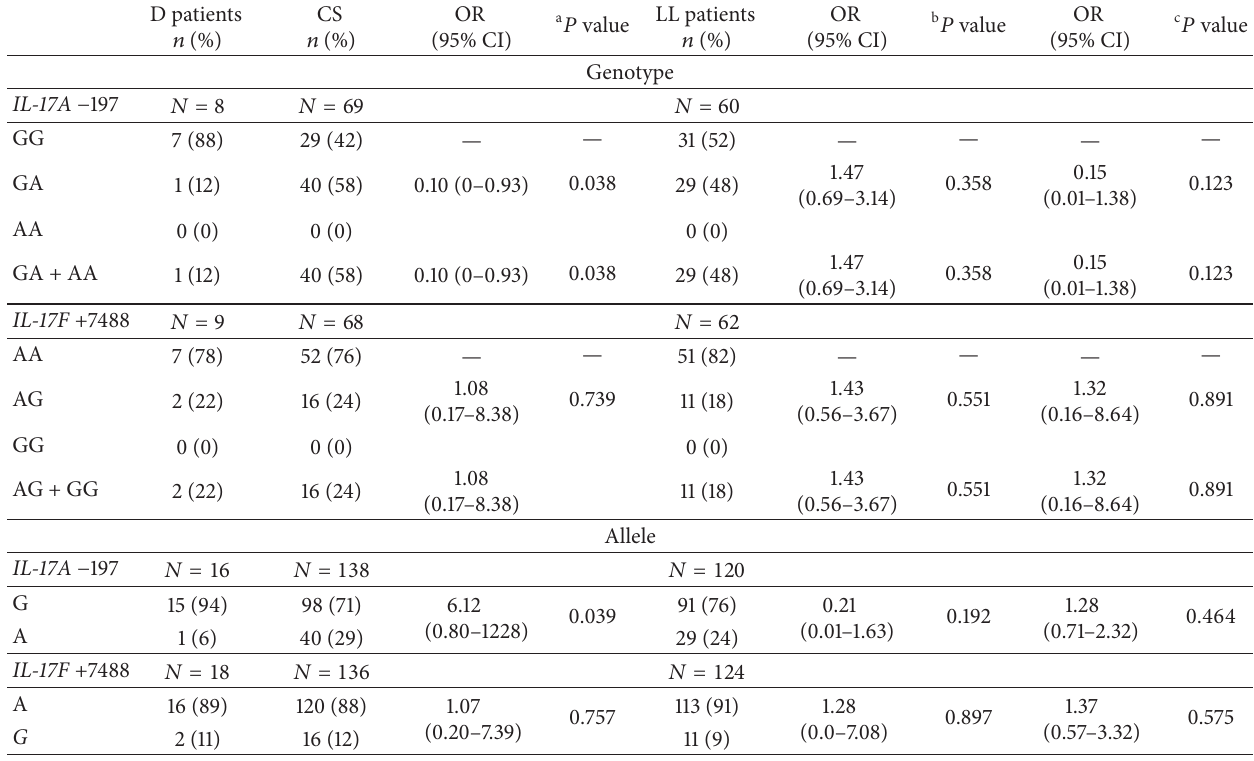
Table 2: Allelic and gene frequencies of polymorphisms in IL-17A and IL-17F genes in subclinical forms (LL and D) and healthy controls. D patients 𝑛